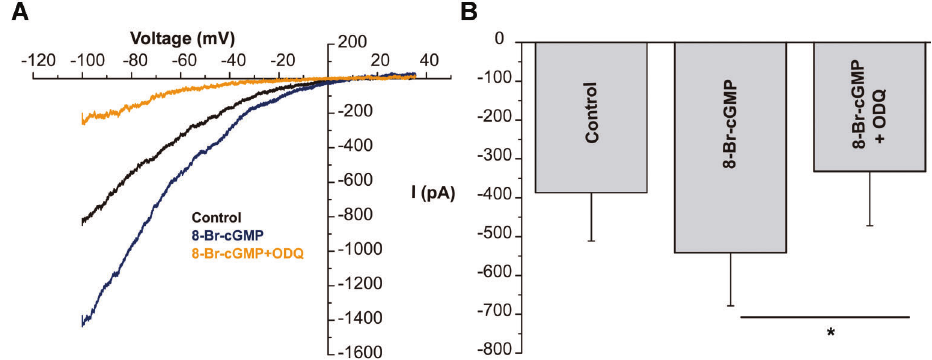
Figure 7. NO modulates purinergic current by the cGMP pathway. A , I (cid:2) V plots for the ATP-evoked currents in control condition (black), after 10 min of treatment with 8-Br-cGMP (dark blue), and after 10 min incubation with 8-Br-cGMP + ODQ (orange). The bar graph in B shows the mean ± SE amplitude of the ATP current at – 70 mV. Note the signi fi cant amplitude decrease after the soluble guanylate cyclase (sGC) enzyme inhibition. *P p 0.05, n=6 cells (ANOVA and Tukey